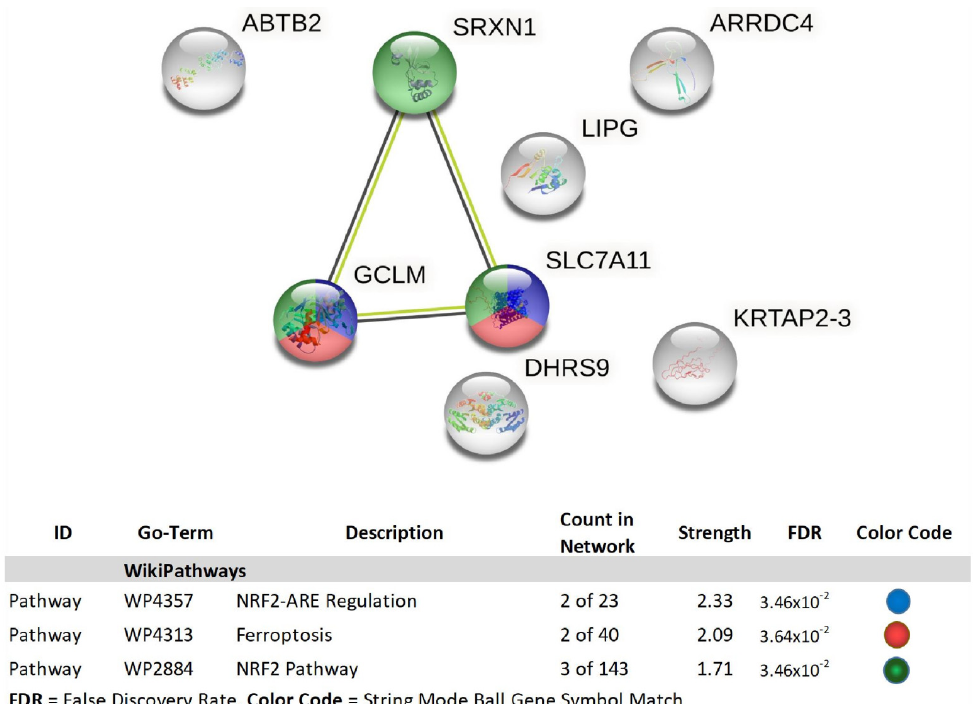
Figure 9. Classification of up-regulated DEGs by GNE-140 in MDA-MB-231 cells, determined using Protein–Protein Interactive String Database analysis. The diagram data are presented as gene symbol and are color-coded by category in the database analysis table. String analytical tables provide the database used, the ID within that database of the recognized related change, the description of the pathway, count in network, strength of association, FDR p -value, and color code for genes involved in that network.